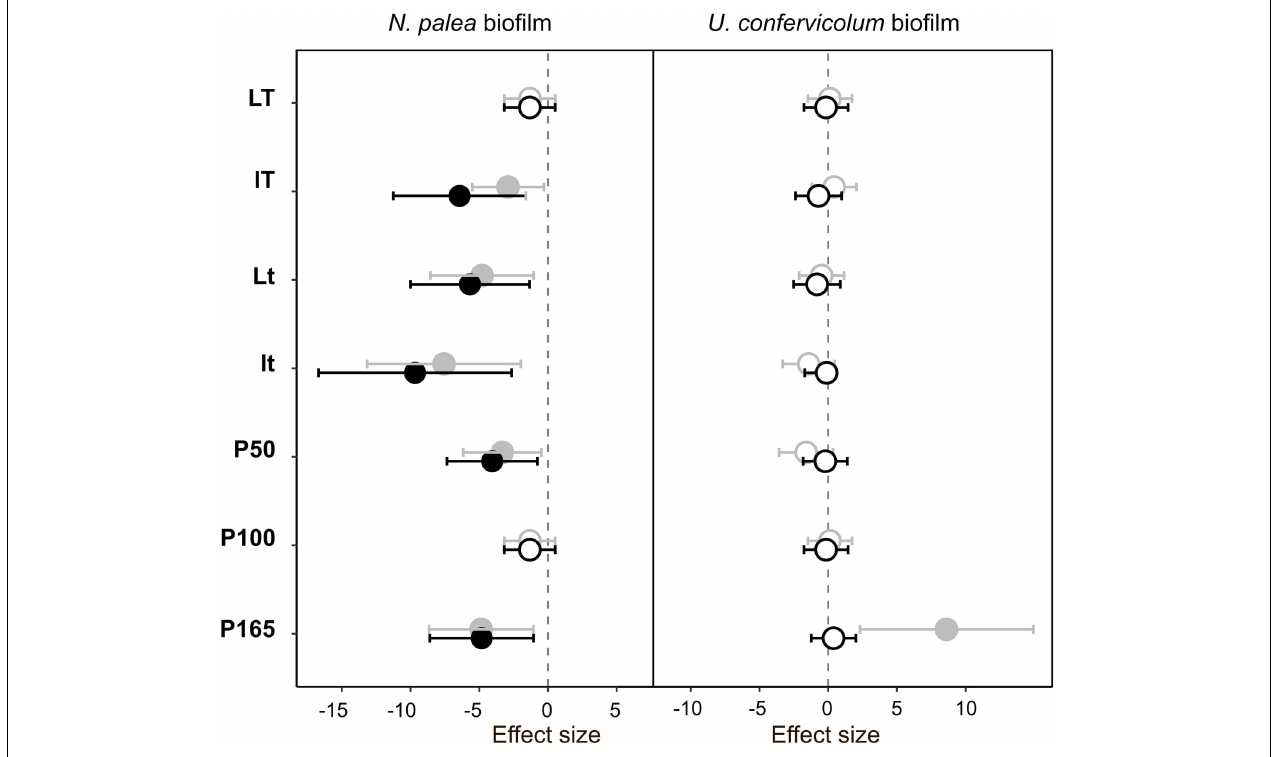
FIGURE 5 | Effect size (Hedges’s ± 95% confidence interval) on the protein/polysaccharide ratio (EPS quality) measured before the disturbance and at the end of the disturbance (gray circles) or before the disturbance and at the end of the rewetting period (black circles), for the N. palea biofilm and U. confervicolum biofilm. The effect size was measured for each growth condition. Full circles: significant effects, open circles: non-significant effects. L / l : high/low light intensity (P100), T / t : high/low temperature (P100), P50, P100, P165: 50, 100, and 165% of the standard initial phosphorous concentration, respectively, associated with L and T conditions.